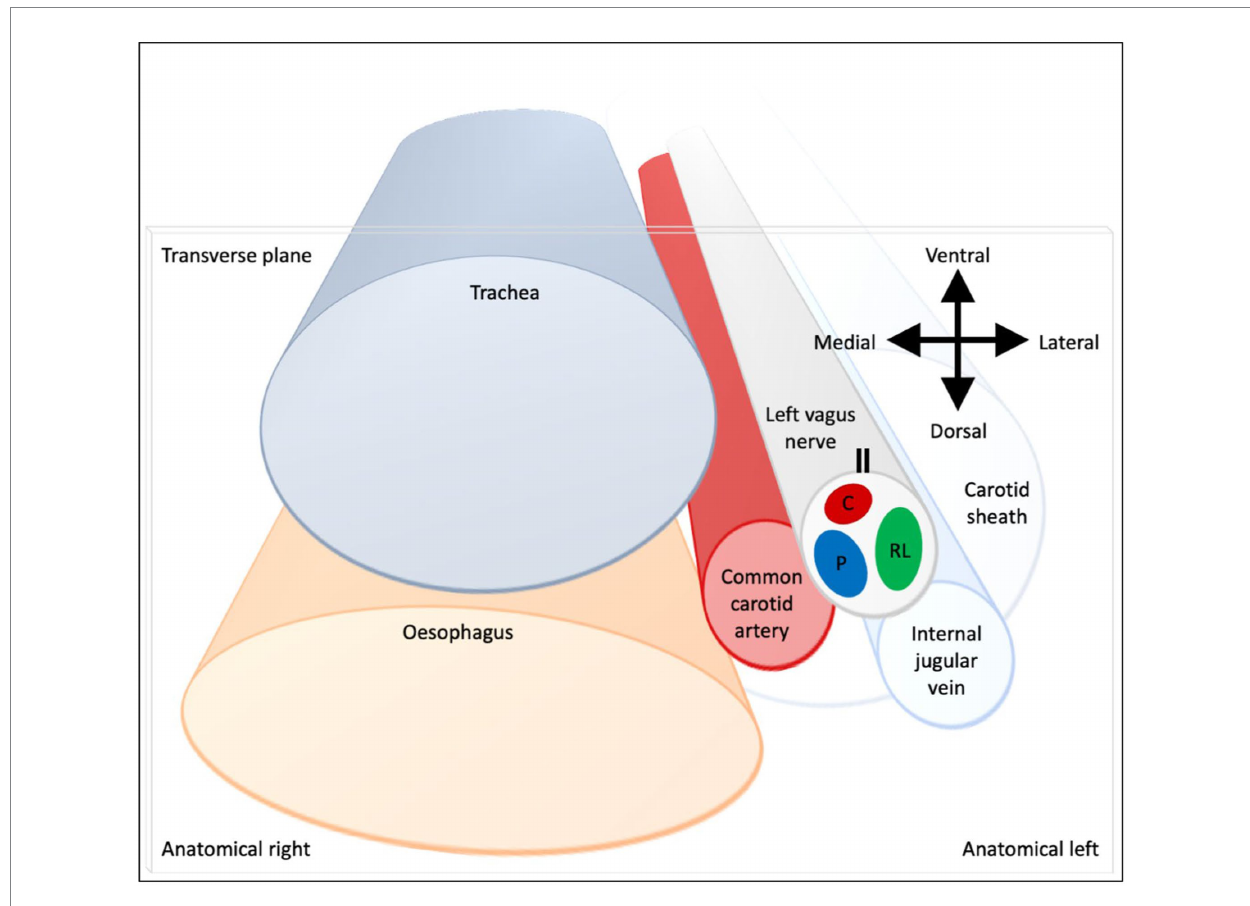
FIGURE 9 Schematic of anatomical location of fascicular regions of the left vagus nerve within the pig with a caudal to cranial view. The opening of the cuff is indicated with a double black line and the fascicular groups have a clockwise order of laryngeal (green), pulmonary (blue) and cardiac (red). This is a representative schematic of the overall organization observed at the level of the caudal